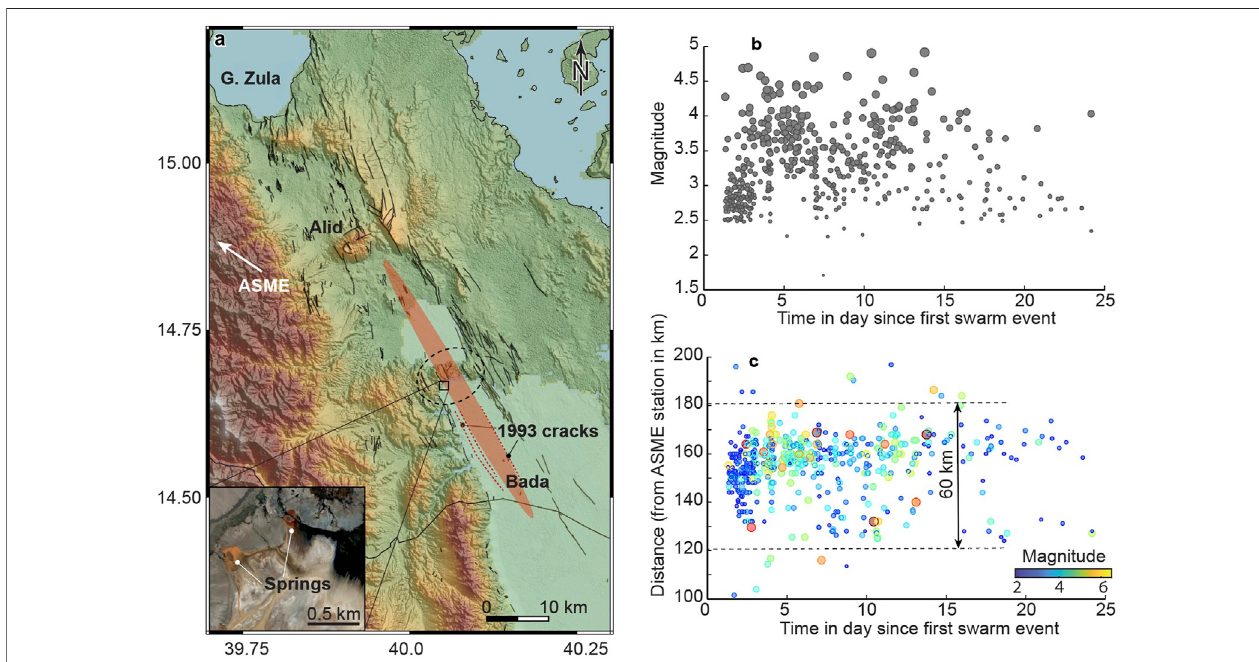
FIGURE 6 | The May 1993 Bada earthquake swarm in Eritrea. (A) Map of the Bada region, northern Afar, with the transparent elongated red ellipse showing the approximateextensionofthe1993Badaswarmalonga60-km-longriftsegmentthatwasactivatedduringthisswarm.Insetshowsthelocationofferruginousspringsat the periphery of a doming area (the dashed circle). (B) Earthquake magnitudes with time show a typical swarm pattern with multiple max-magnitude events during the swarm and absence of a mainshock at the beginning of the sequence. (C) Distance of the swarm earthquakes from the ASME seismic station (see white arrow for the ASME direction located in Asmara; see Figure 1 for location) versus time for the 25 days the swarm